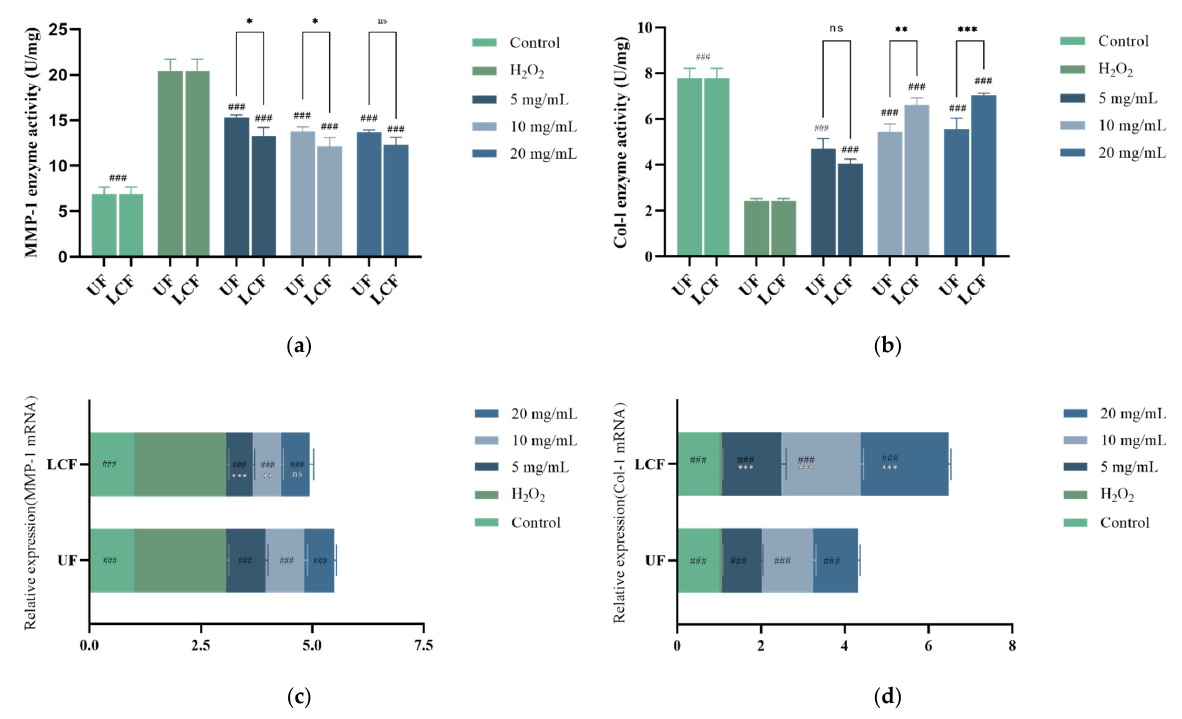
Figure 12. Effects of UF and LCF on content and expression level of MMP-1 and COL-1: ( a , c ) effects on content and expression level of MMP-1 and mRNA; ( b , d ) effects on content and expression level of COL-1 and mRNA. UF: unfermentation; LCF: single microbial fermentation with L. curvatus . Analysis of significant differences between each group and H 2 O 2 model group, ###: p < 0.001.; comparison of each group between UF and LCF, *: p < 0.05; **: p < 0.01; ***: p < 0.001 ; ns: p > 0.05.